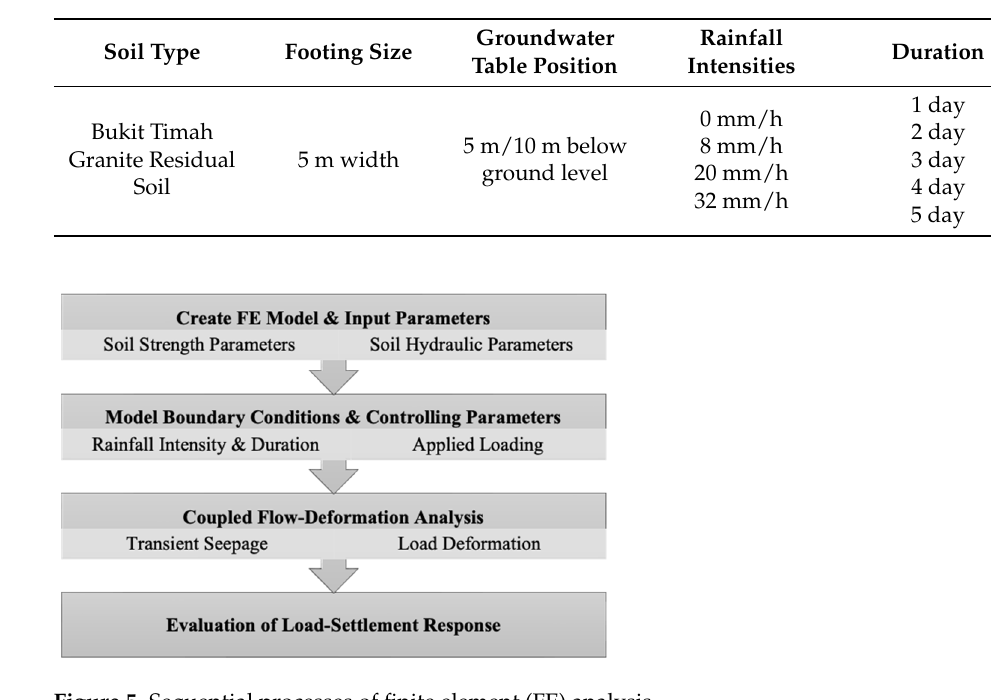
Table 2. Summary of controlling parameters used in the simulations.